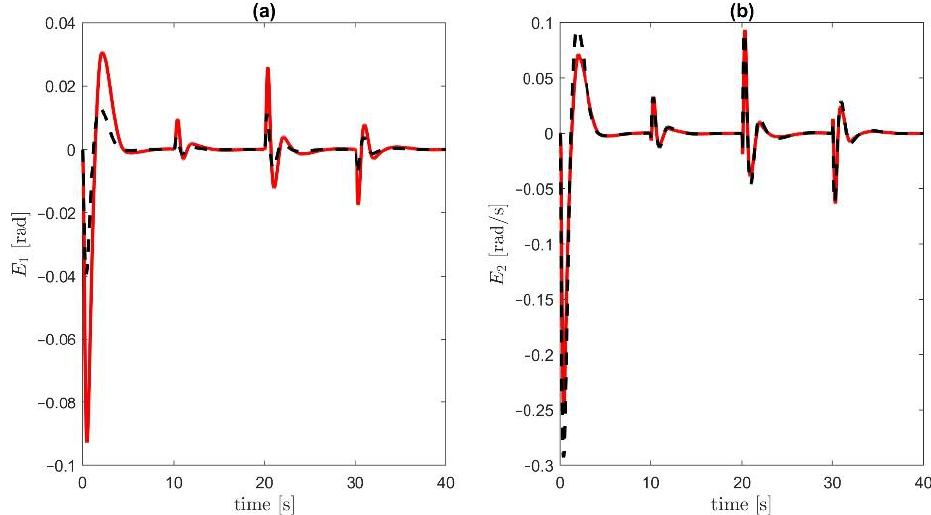
Figure 13. ( a ) Tracking error 𝐸 1 , ( b ) tracking error 𝐸 2 . Dashed black line — 𝑘 1 = 𝑘 2 = 𝑘 3 = 𝑘 4 = 5 , solid red line — 𝑘 1 = 𝑘 2 = 𝑘 3 = 𝑘 4 = 15 .